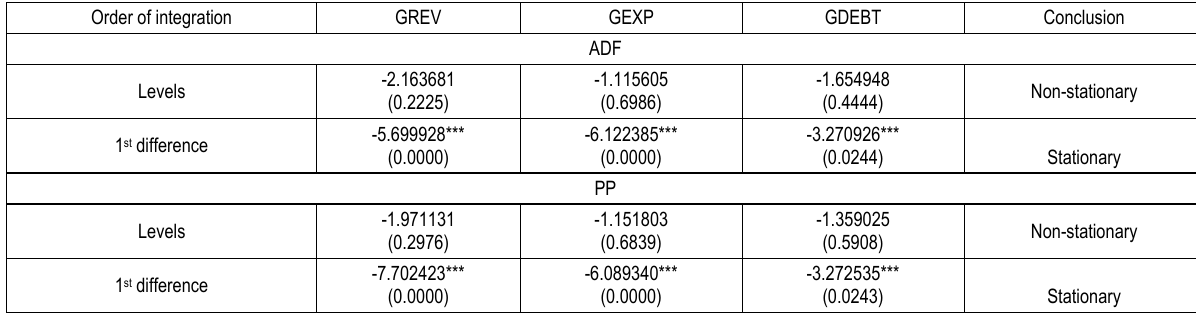
Table 4. ADF and PP test results